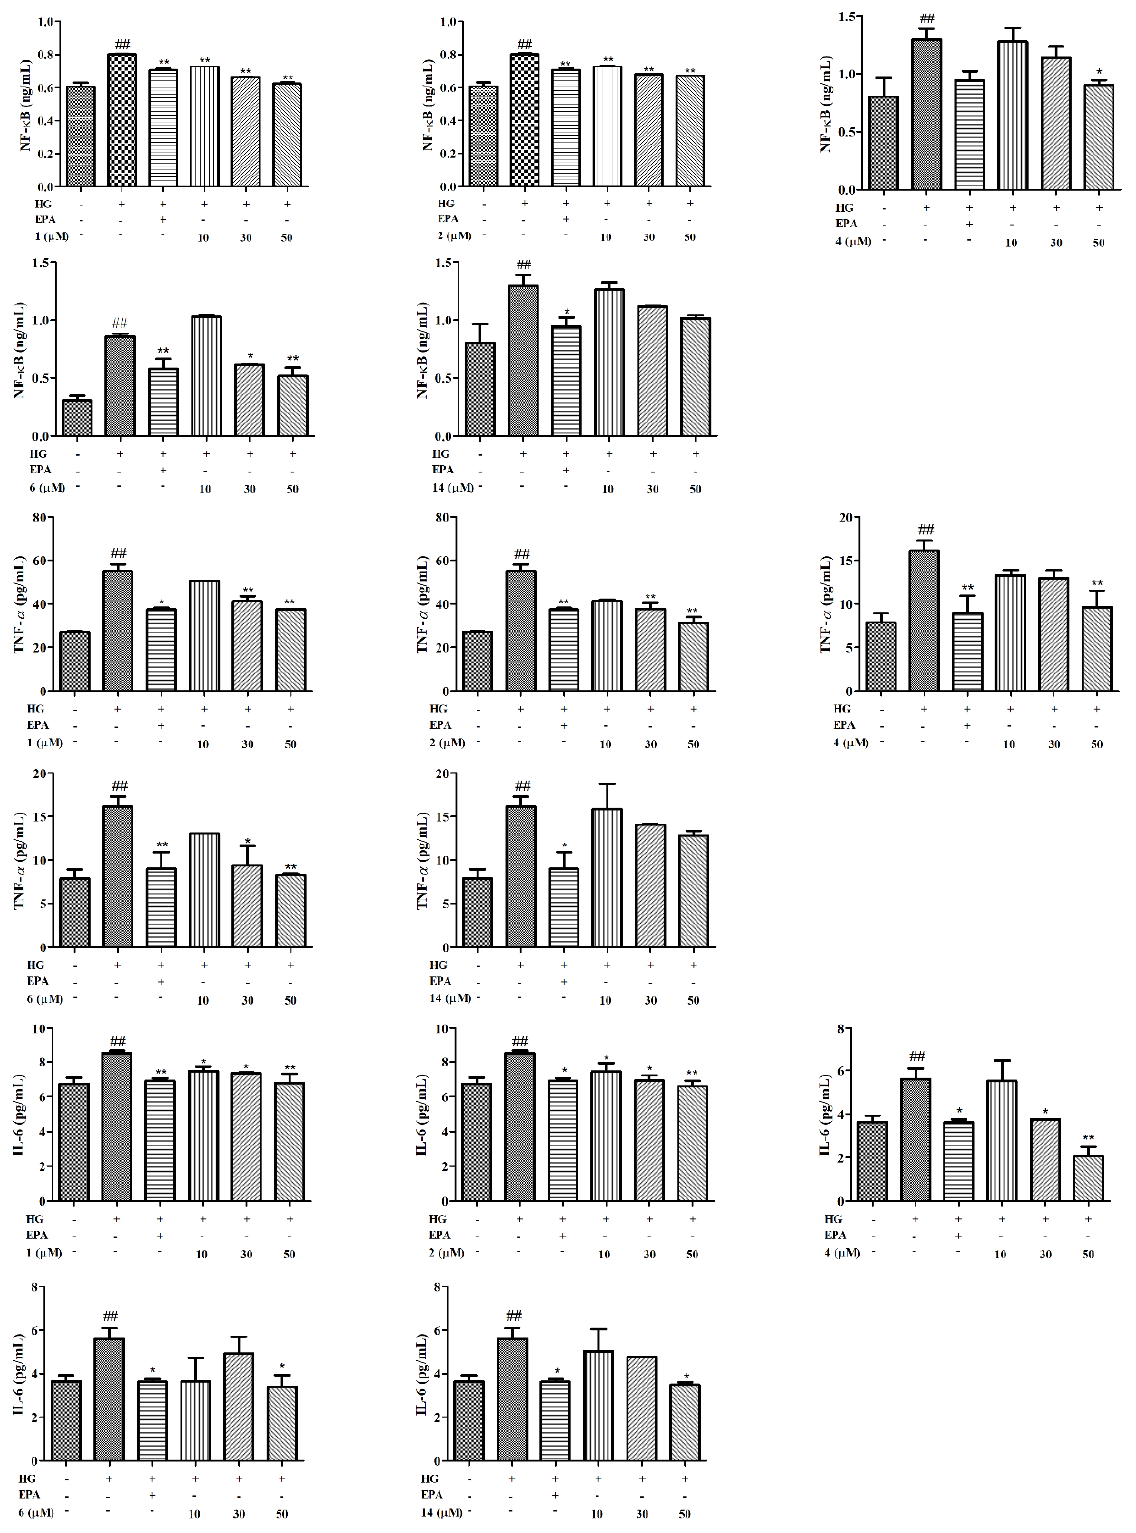
Figure 6. Effects of compounds on inflammation in GMCs. The GMCs were treated with or without compounds 1 , 2 , 4 , 6 , 14 at concentrations of 10, 30, and 50 µ M in HG for 48 h. The expressions of NF- κ B, TNF- α , and IL-6 were analyzed using commercially available Elisa kits. Values are expressed as mean ± SD of three independent experiments, with ## p < 0.05 relative to the NG and * p < 0.05 or ** p < 0.01 relative to the HG